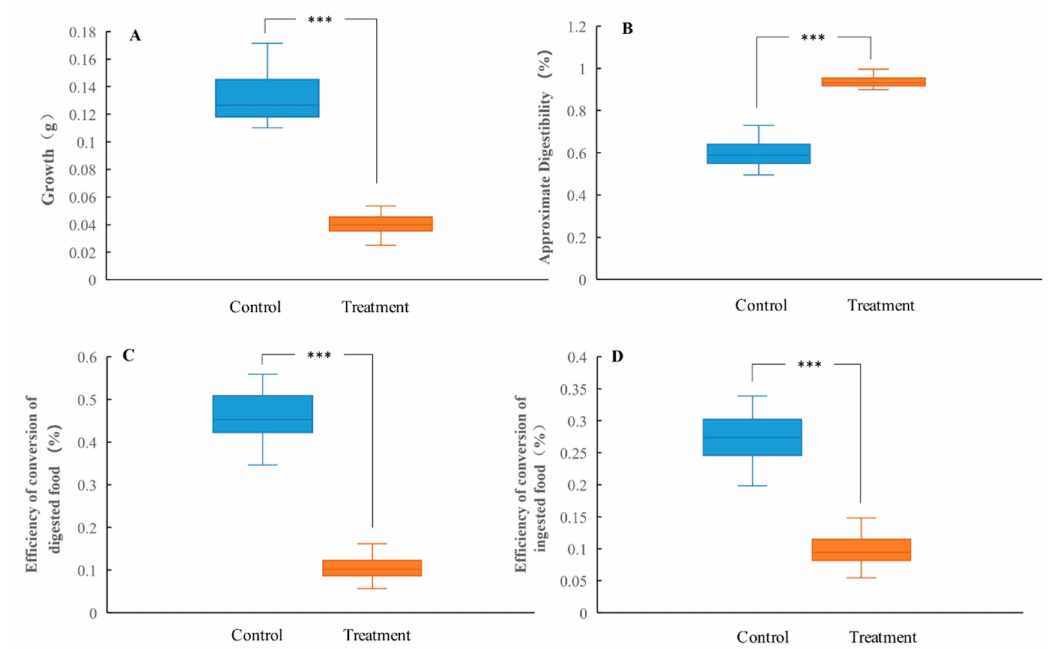
Figure 1. Effect of tannic acid on the growth ( A ), approximate digestibility ( B ), efficiency of conversion of digested food ( C ), and efficiency of conversion of ingested food ( D ) in the H. cunea larvae at the 6th instar. Asterisk indicates significant differences between control/treatment groups ( n = 30; independent samples t -test; ***, p < 0.001).